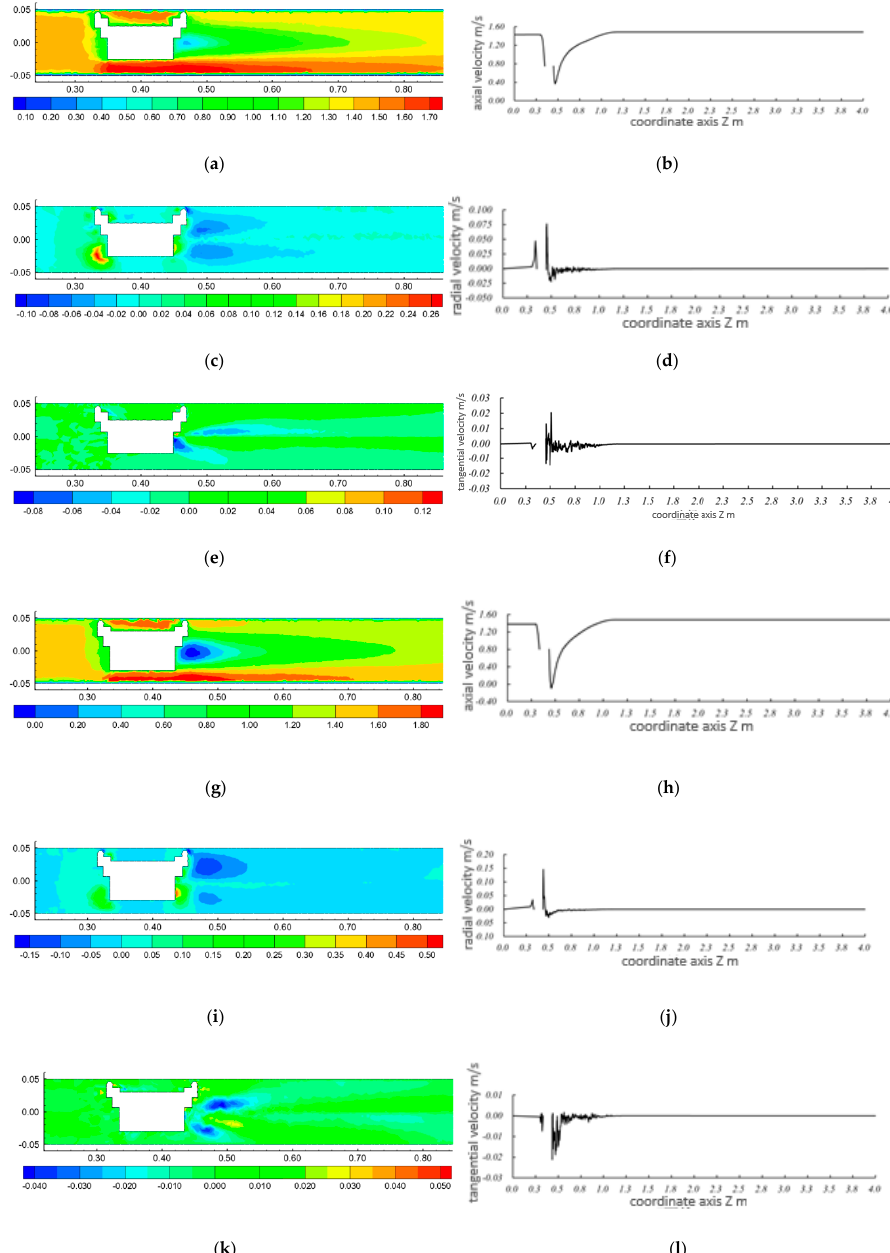
Figure 14. Overall flow field distribution during movement of the capsule: ( a ) axial velocity distribution in X = 0 section, L/D = 2; ( b ) axial velocity distribution along pipeline center points, L/D = 2; ( c ) radial velocity distribution in X = 0 section, L/D = 2; ( d ) radial velocity distribution along pipeline center points, L/D = 2; ( e ) circumferential velocity distribution in X = 0 section, L/D = 2; ( f ) circumferential velocity distribution along pipeline center points, L/D = 2; ( g ) axial velocity distribution in X = 0 section, L/D = 1.67; ( h ) axial velocity distribution along pipeline center points, L/D = 1.67; ( i ) radial velocity distribution in X = 0 section, L/D = 1.67; ( j ) radial velocity distribution along pipeline center points, L/D = 1.67; ( k ) circumferential velocity distribution in X = 0 section, L/D = 1.67; ( l ) circumferential velocity distribution along pipeline center points, L/D = 1.67.